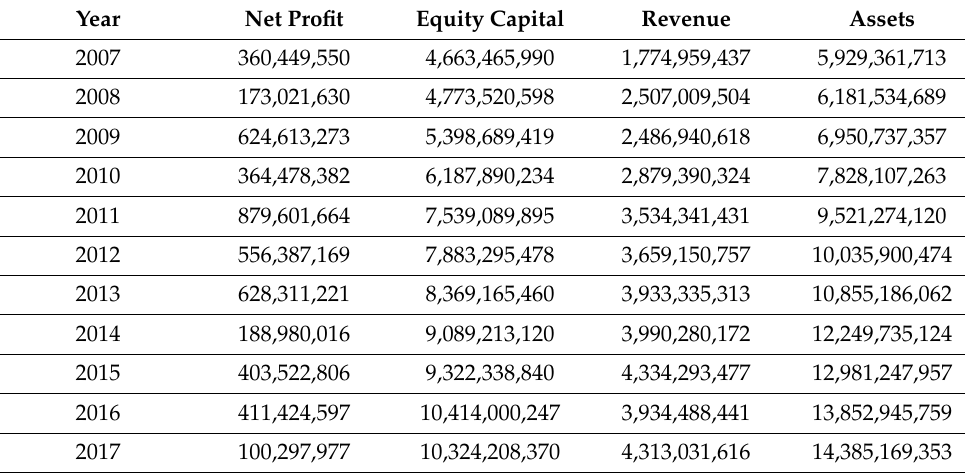
Figure 2. The algorithm of functioning of factor models for financial analysis 2 DP , Table 2. Statistical data for factor analysis of the functioning of the PJSC